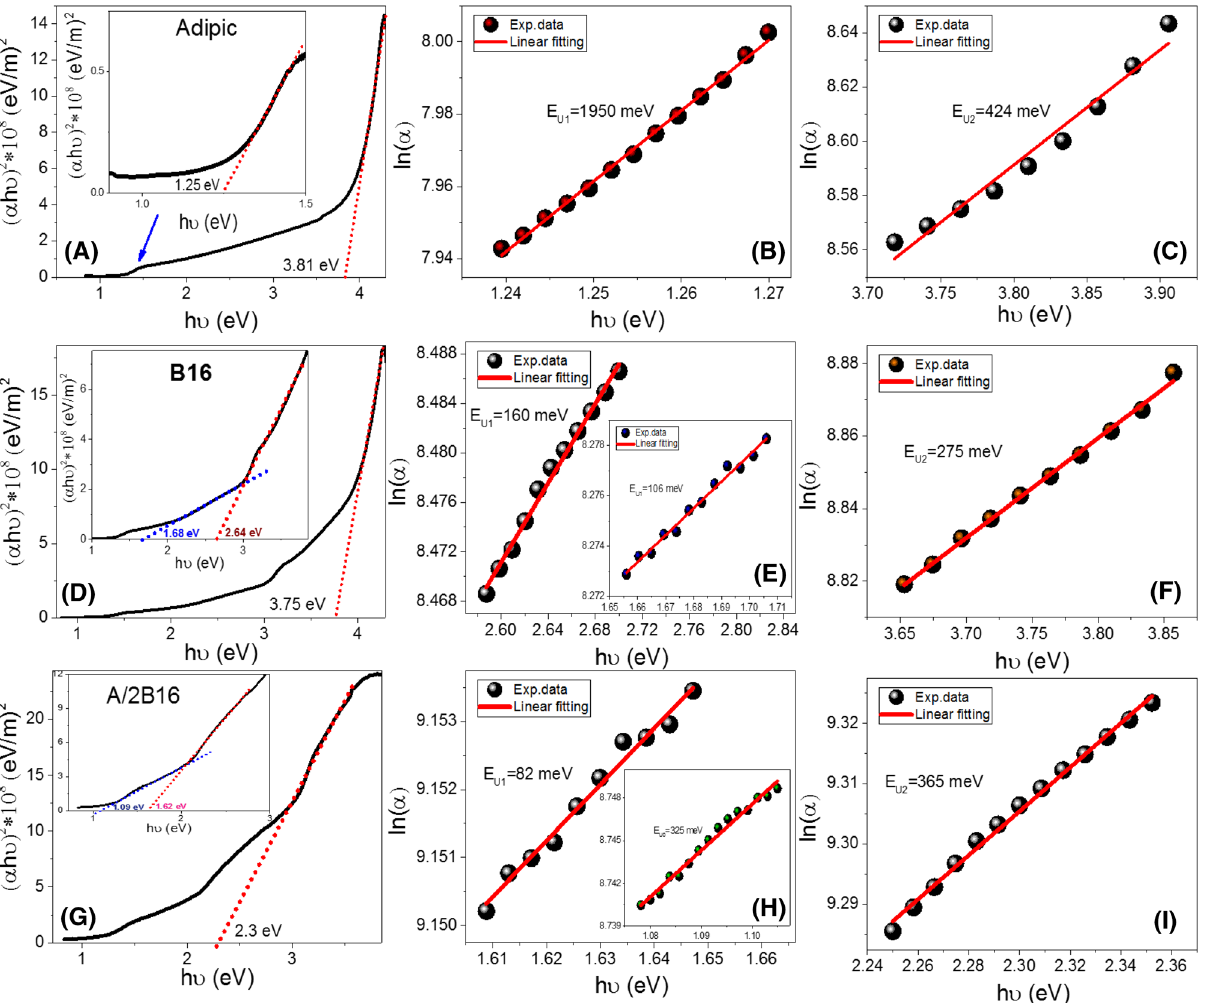
Figure 13. Calculation of energy gap ( A , D , G ) and Urbach energy ( B , C , E , F , H , I ) for individual components A , B16, and their supramolecular complex A/2B16